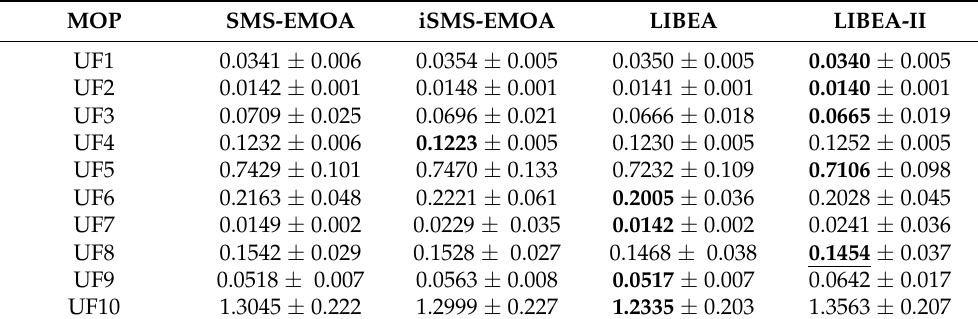
Table 4. Average IGD + values for the non-dominated solutions found by the IBEAs to each UF test